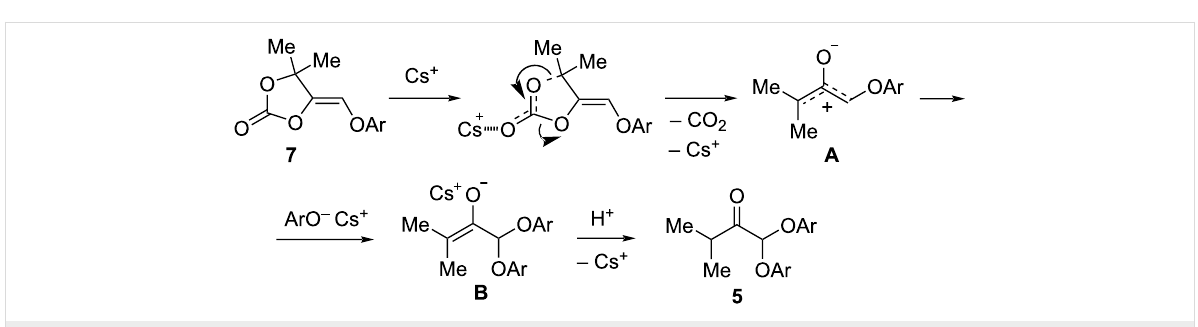
Scheme 8: A plausible mechanism for the formation of diphenoxyketone 5 .